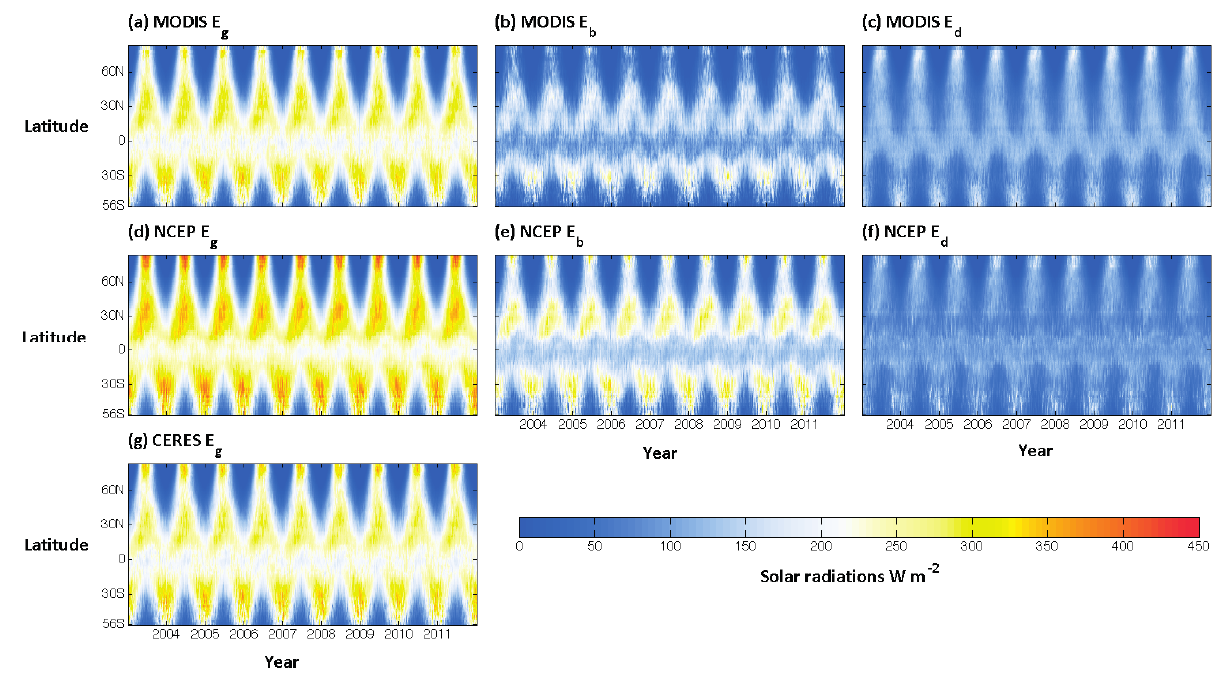
Figure 5. Comparison of the temporal variation of the MODIS ( a – c ), NCEP ( d – f )